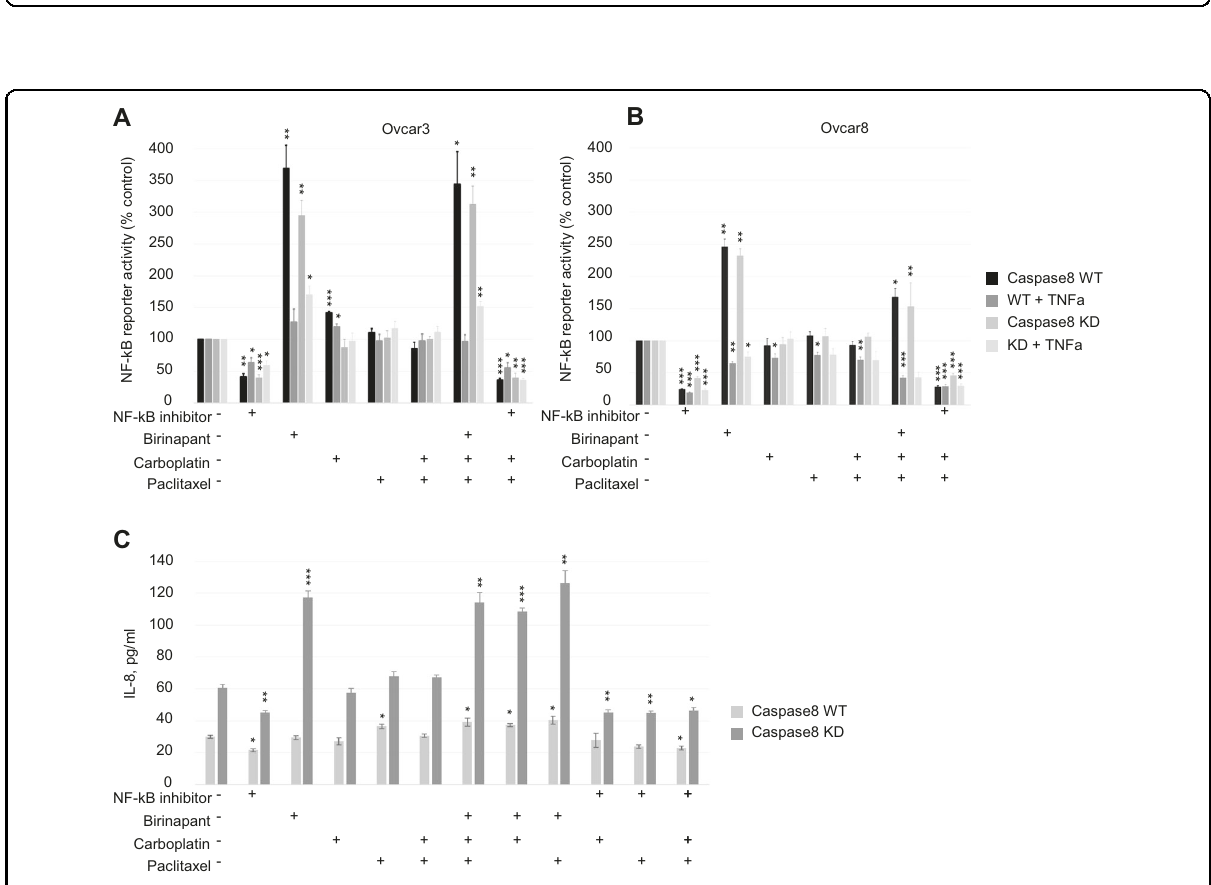
Fig. 4 In vitro birinapant treatment inhibits TNF α -induced NF κ B activity in NF κ B-independent ovarian cancer cells. A , B NF κ B signaling in each Caspase 8 WT and Caspase 8 KD Ovcar3 ( A ) and Ovcar8 ( B ) cell lines expressing a reporter was measured with luminescence. Cells were treated with simultaneous combinations of carboplatin, paclitaxel, birinapant, and IKK β inhibitor IV for 18 h as indicated, and TNF α (10 ng/ml) added for the last hour. Data are arbitrary luciferase units normalized to viable cell number, n = 8, expressed as percentage of vehicle control. C IL-8 cytokine levels in Ovcar8 Caspase 8 WT and Caspase 8 KD cell lines after treatment with chemotherapy, birinapant, or IKK β inhibitor IV for 18 h, as described, n = 8. Values are